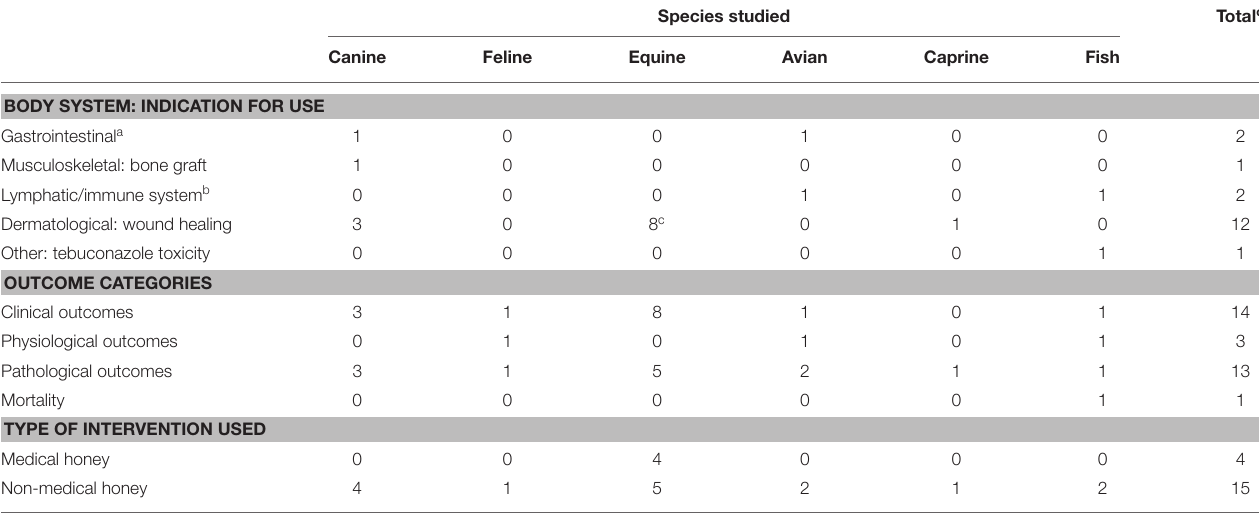
TABLE 4 | Summary of 18 veterinary challenge trials included in a scoping review of the evidence for the medicinal use of honey in animals, characterised by species, indication for use, outcome category and type of honey used.